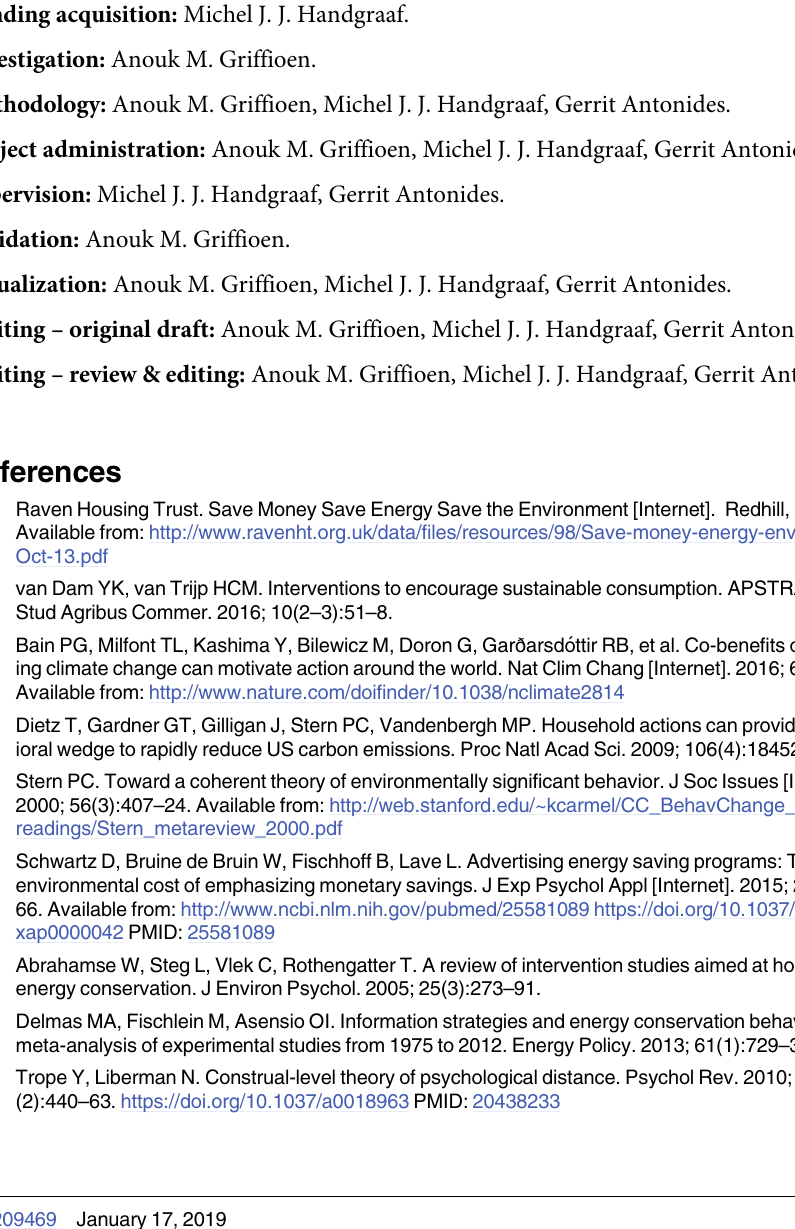
S1 Fig. Absolute change in water use throughout 6-week intervention period compared to baseline.